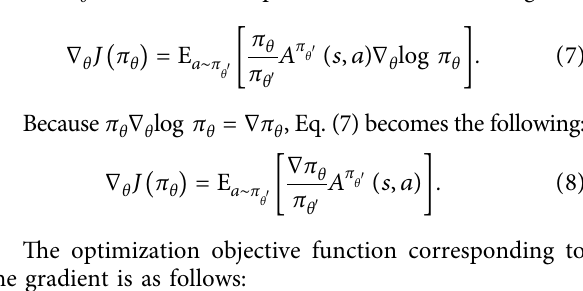
algorithm achieves a balance between sampling efficiency, algorithm performance, and engineering implementation complexity.